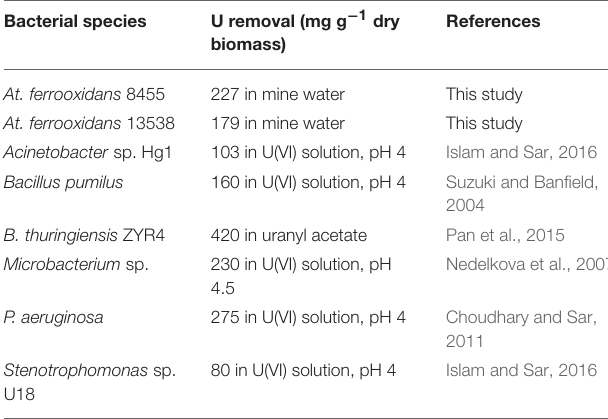
TABLE 1 | Efficiency of different bacteria species biomass (mg g − 1 dry biomass) for the removal of U(VI) compared to At. ferrooxidans strains. Bacterial